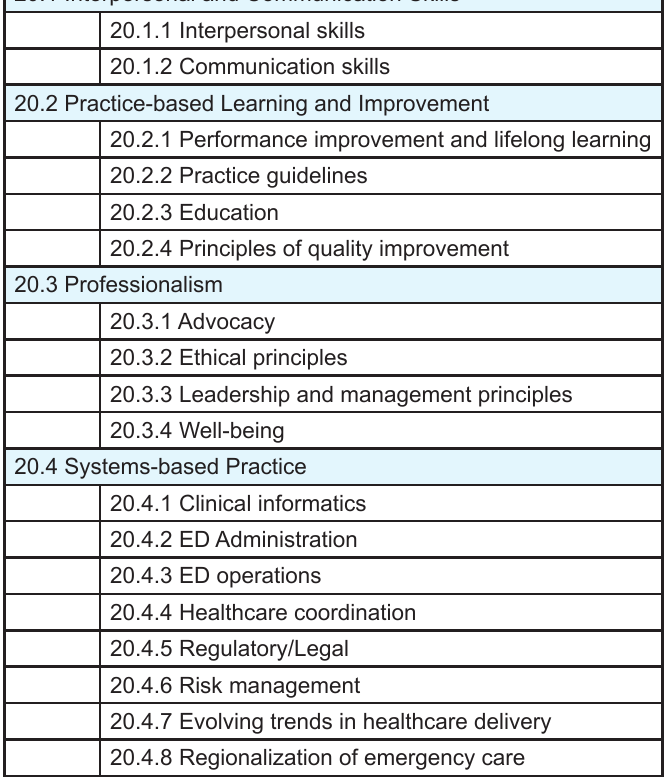
Figure 2. Subtopics under “20.0 Other Core Competencies of the Practice of Emergency Medicine” category in the 2016 ABEM EM